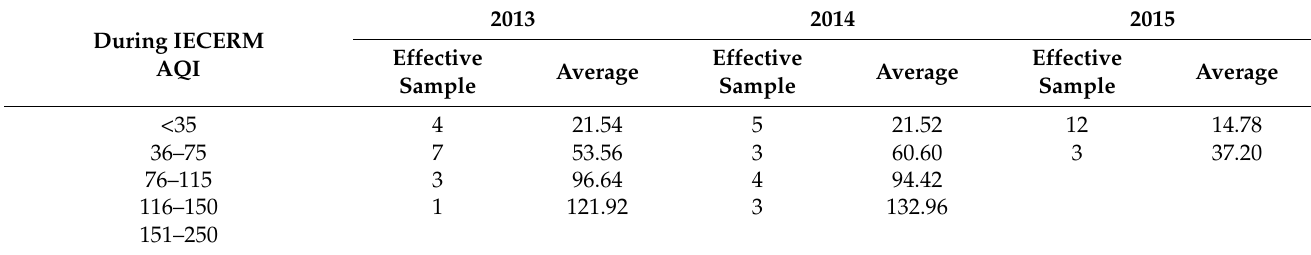
Table 5. Changes in AQI over the same period from 2013 to 2015 during the